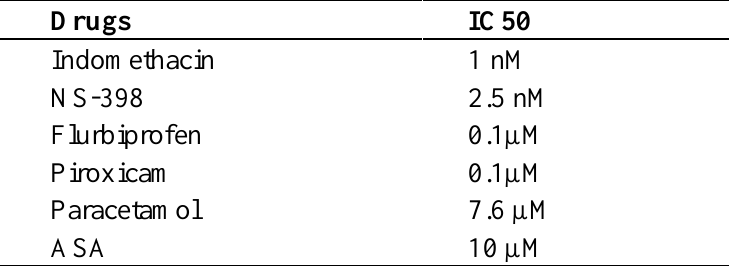
Rat microglial cells were incubated for 24 h at 37 °C with 10 ng/mL LPS in the presence of increasing concentrations of each drug (0.1 nM–100 µM). None of the basal level. IC values are drugs tested affected PGE 2 50